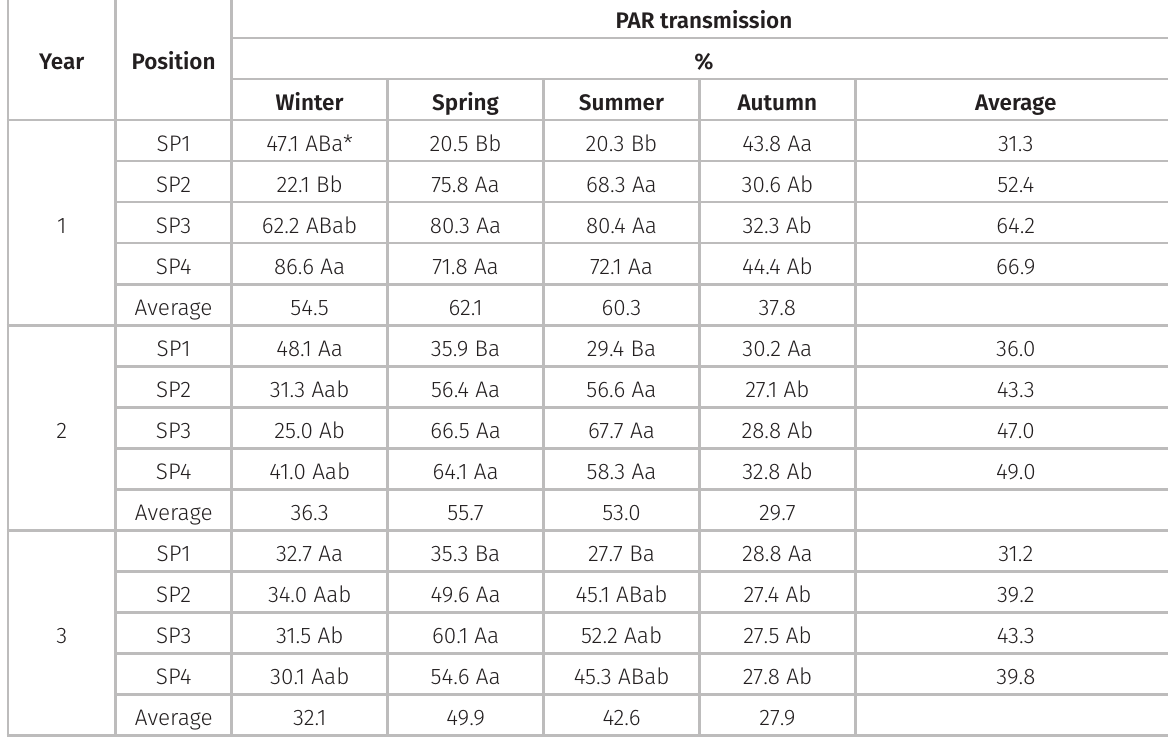
Table IV. Photosynthetically active radiation (PAR) transmission at the four positions within the silvopastoral system (SP1: 0.00 m, SP2: 3.75 m, SP3: 7.50 m and SP4: 11.25 m from the North row), in each season of the three study years.